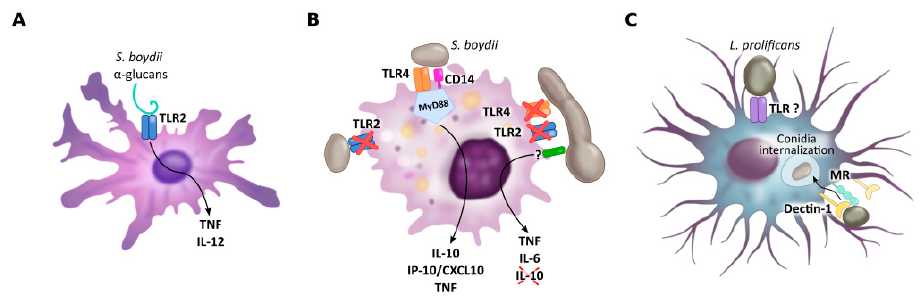
Figure 2. PRRs of dendritic cells ( A ), macrophages ( B ) and microglial cells ( C ) implicated in Scedosporium/Lomentospora recognition. Dendritic cell TLR2 is necessary for α -glucans recognition and consequent IL-12 and TNF secretion. Macrophage TLR4, together with CD14 and MyD88, but not TLR2, is required to induce macrophage activation by conidia, whereas hyphae recognition is independent of TLR2 and TLR4. Microglial cell mannose receptors, but especially Dectin-1, mediate L. prolificans conidia uptake. Other receptors may be involved in this process.